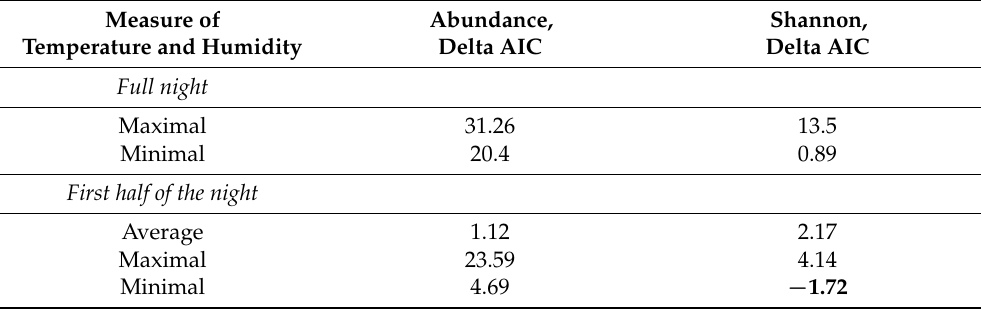
Table 7. Comparison of alternative models to the main models for (1) moth abundance (Table 4) and (2) Shannon diversity (Table 6) based on Akaike Information Criterion. The values of average nightly temperature and humidity (used in the main models) were replaced by alternative measures of these variables (maxima and minima of the full night; averages, maxima and minima for the first half of the night), resulting in five alternative